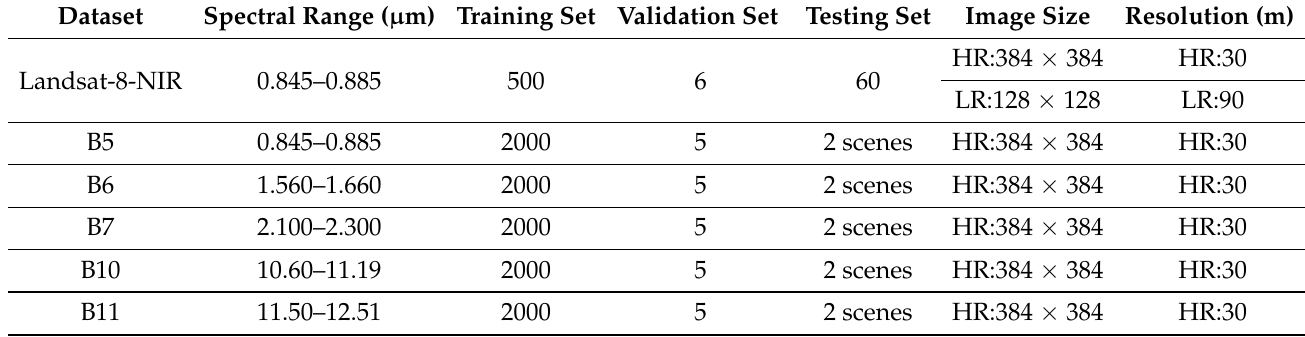
Table 2. The information of Landsat-8 dataset used in this